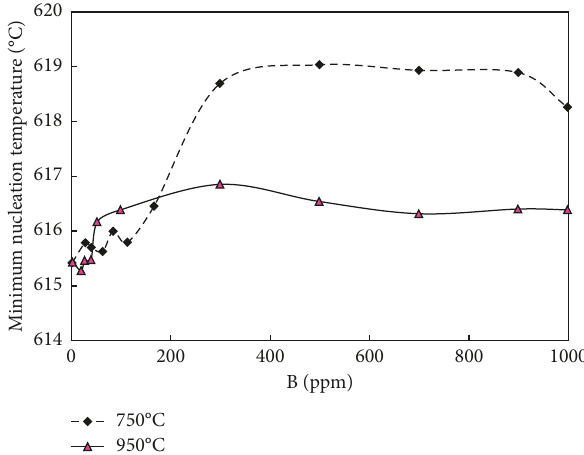
Figure 10: Variation of the nucleation temperature as a function of the added B and melting conditions.